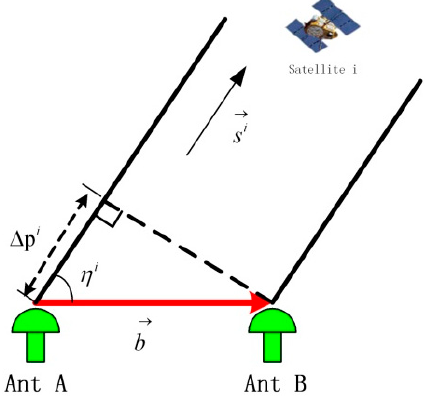
Figure 1. Illustration of the measurement of the SD carrier phase.